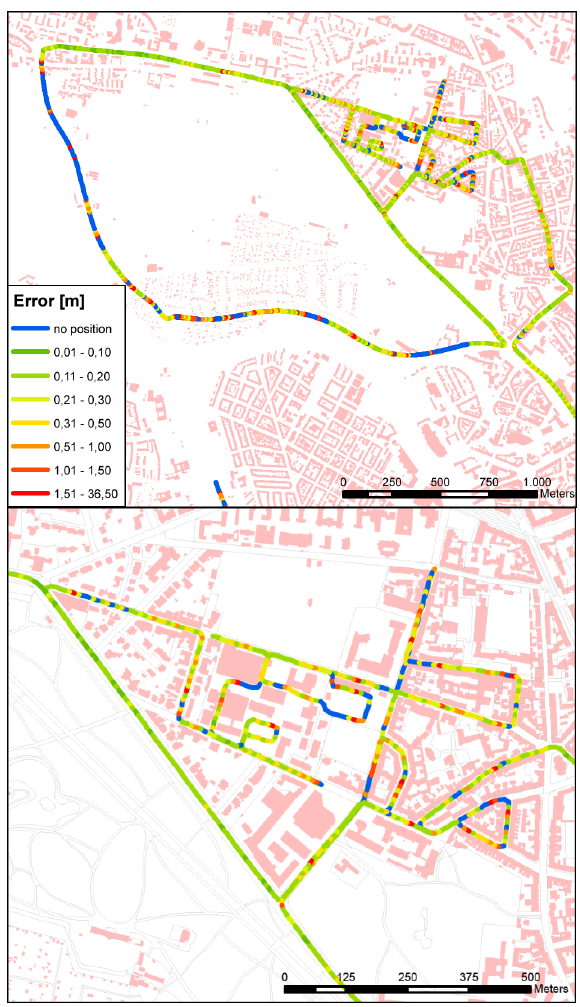
Figure 7. Map of accuracies without filter for a camera system with 100° opening angle.